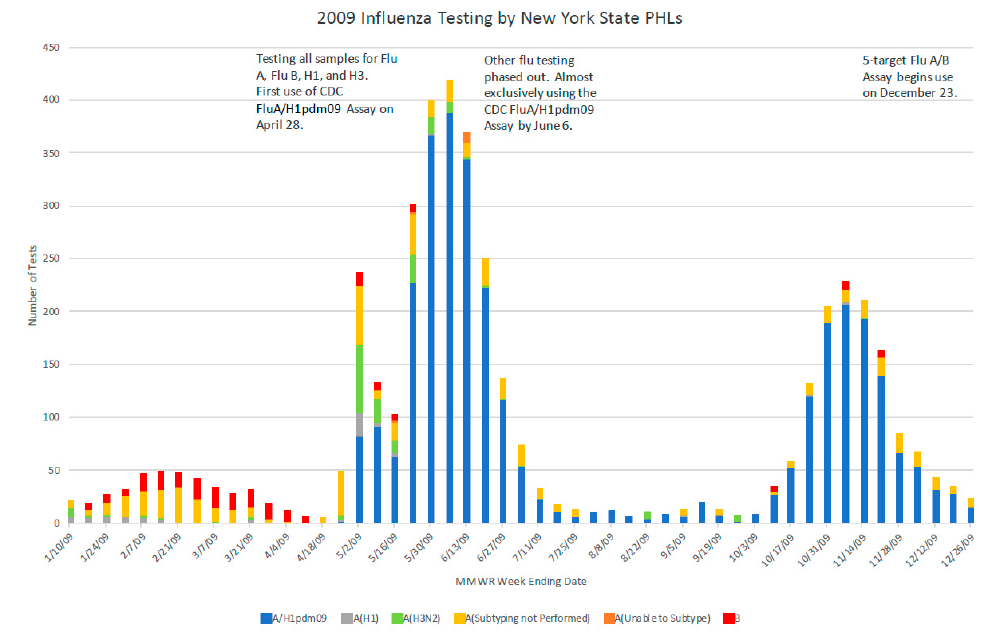
Figure 3. Testing by the Wadsworth Center in 2009 for influenza types and subtypes, identifying the pandemic influenza A/H1N1pdm09 strain once the specific CDC assay became available.